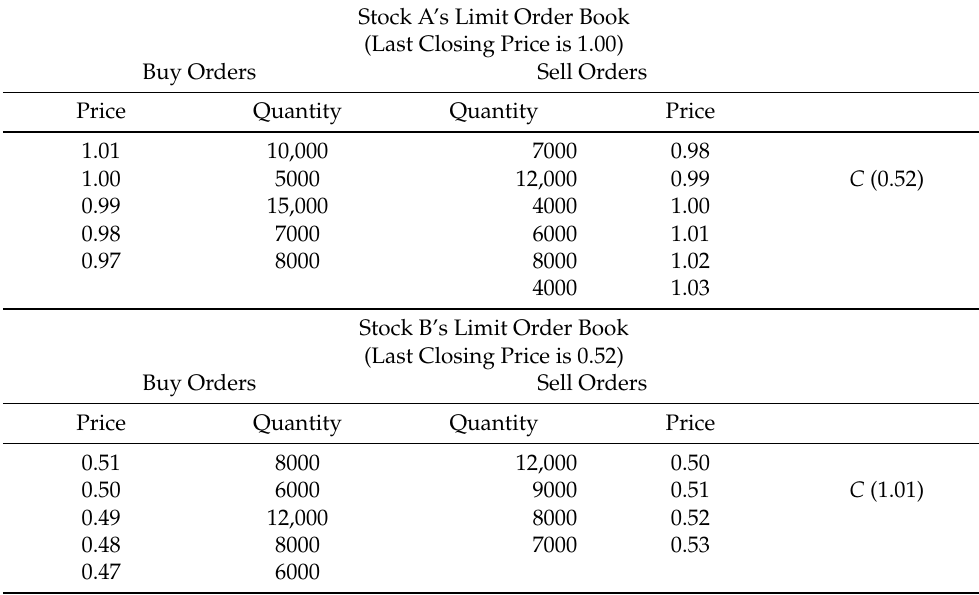
Table 1. Opening Order Books.